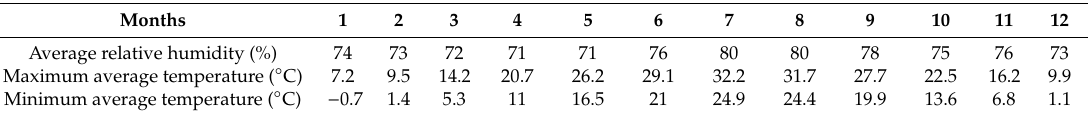
Table 3. Meteorological data of Nanjing City according to a data set of annual and monthly ground values of China (1981–2010).